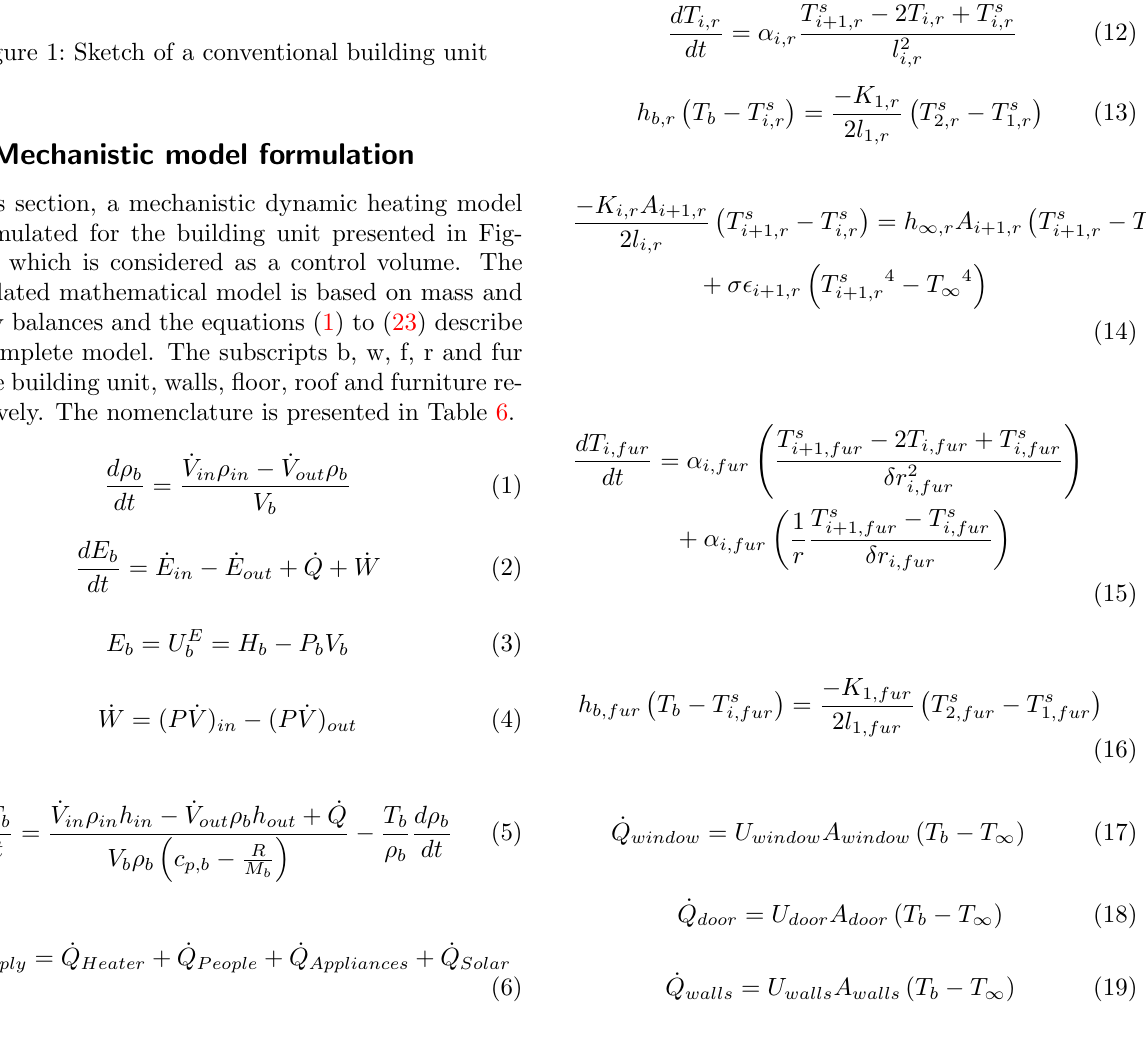
Figure 1: Sketch of a conventional building